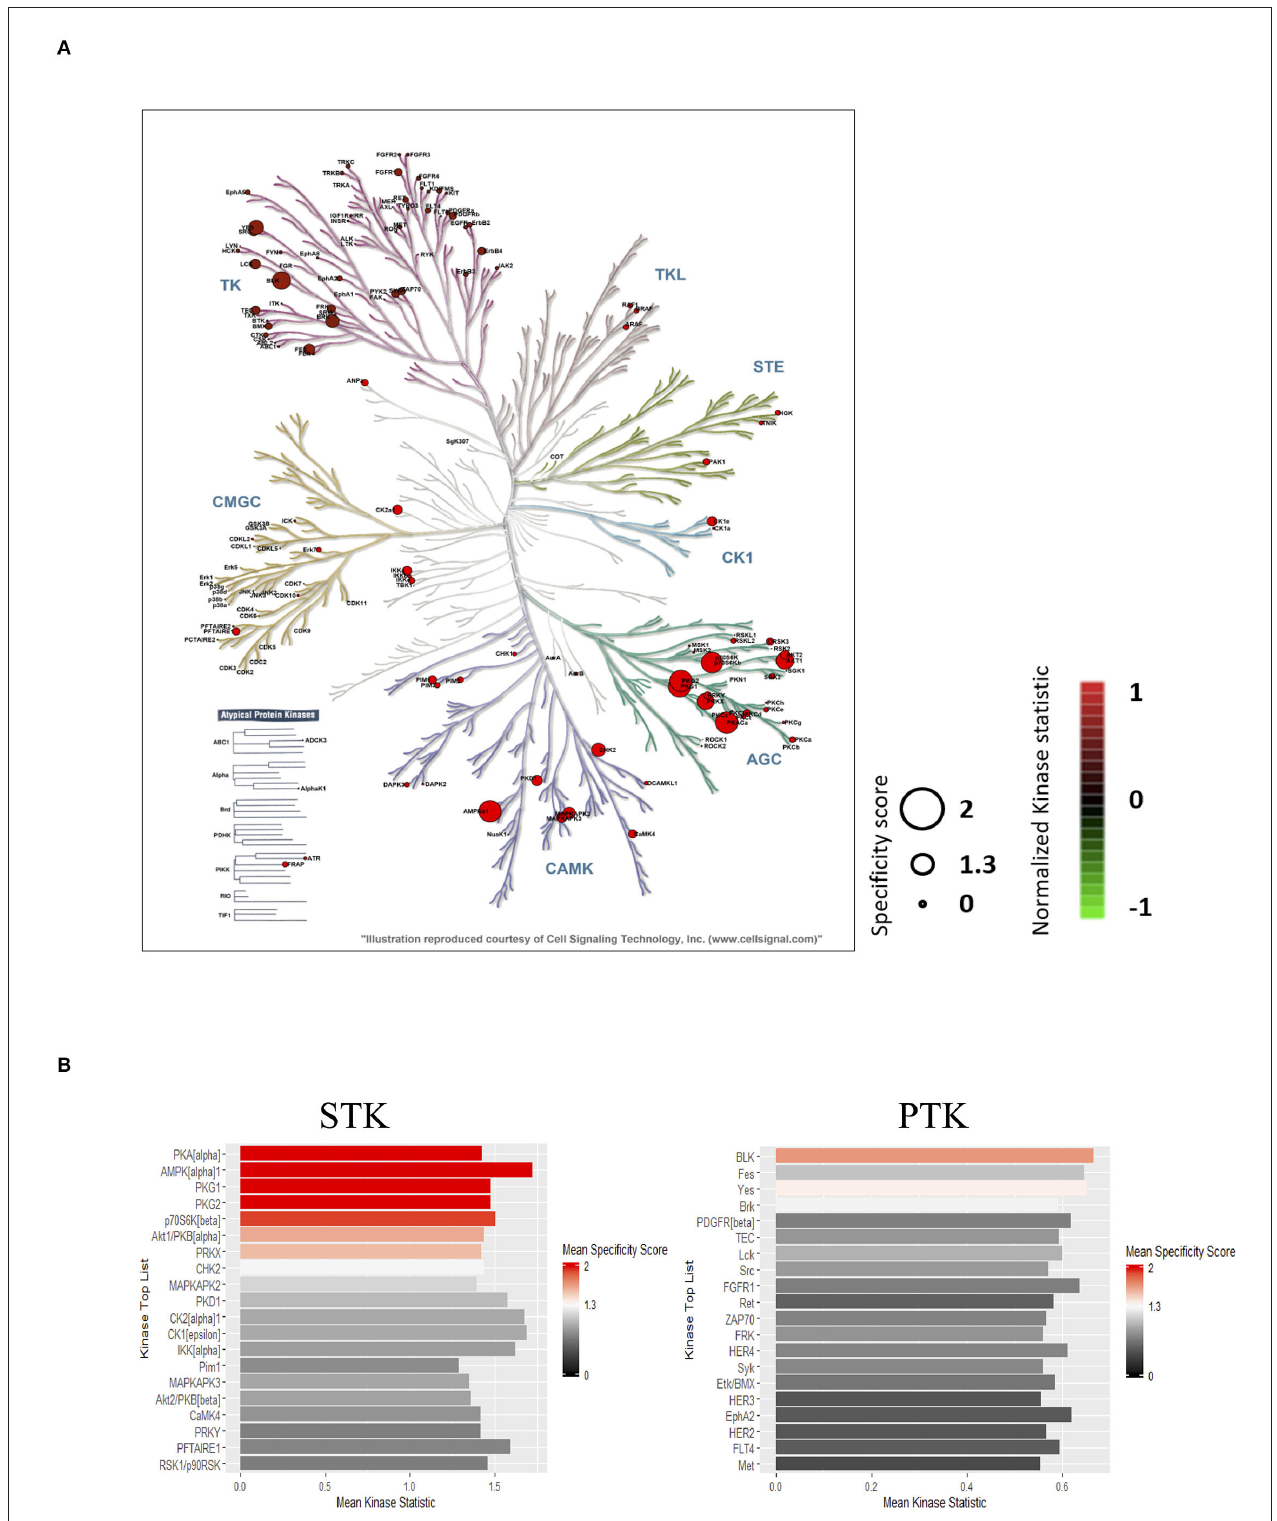
FIGURE 2 | Prediction of the top upstream kinases. (A) Combined STK and PTK kinome tree. Top predicted kinases are represented on phylogenetic tree of the human protein kinase family. Dot size indicates specificity score and color denotes kinases statistic (IHD vs. Ctrl). (B) Kinase score plot. X-axis (Mean Kinase Statistic) indicates the overall change of the peptide set that represents the kinase. Y-axis (Mean Final Score) ranks kinases based on their significance and specificity in terms of the set of peptides used for the corresponding kinase.